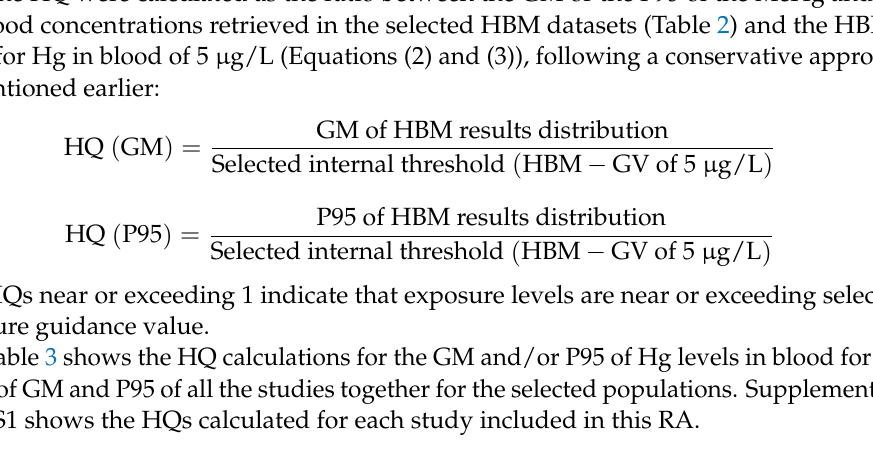
Table 3. HQ calculations for the GM and/or P95 of Hg levels in blood for all HBM studies considered for the selected populations.